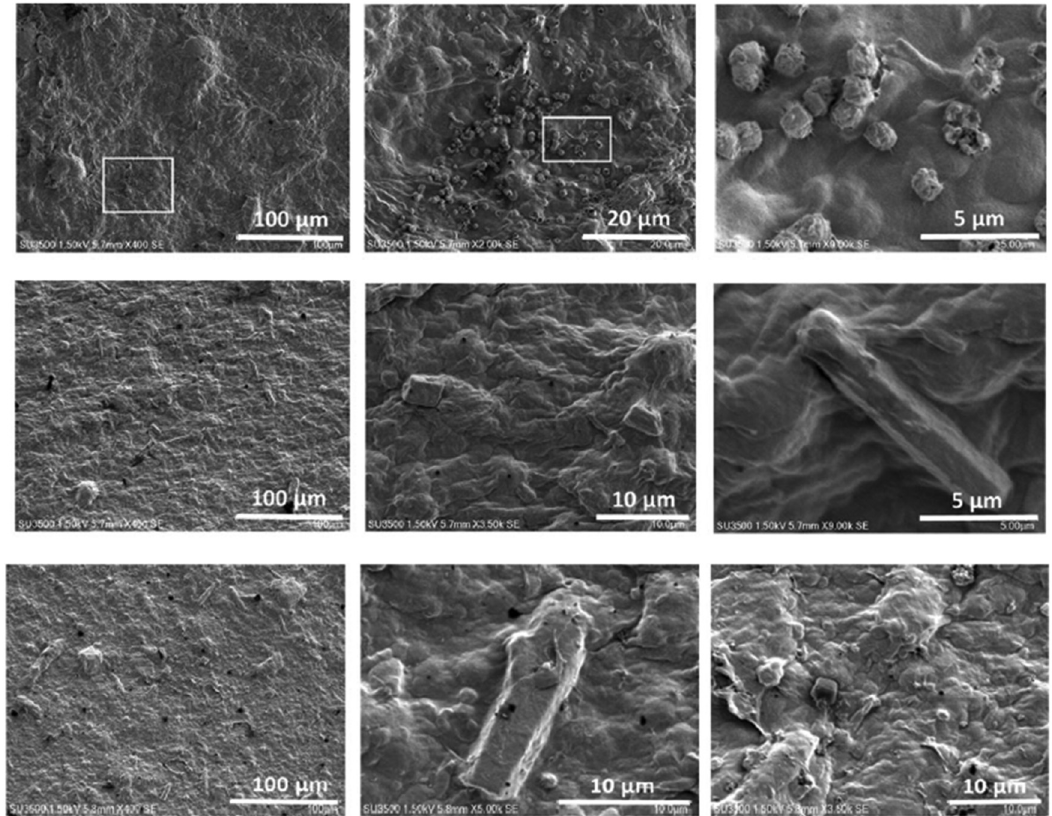
Figure 7: SEM images of ACNF/PCC nanopapers before ( top row ) and after ( middle and bottom row ) ultrasonication. The images ( middle and bottom row ) represent images of composites after use of 80% ultrasonicator power and 30 and 60min treatment, respectively. Adapted from ref. [ 54 ]